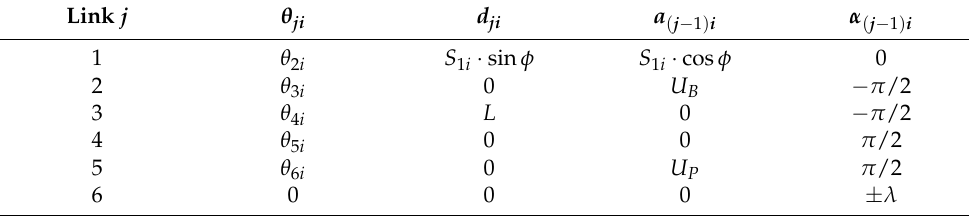
Table 2. D-H parameters of the kinematic chain of the i th leg. Link